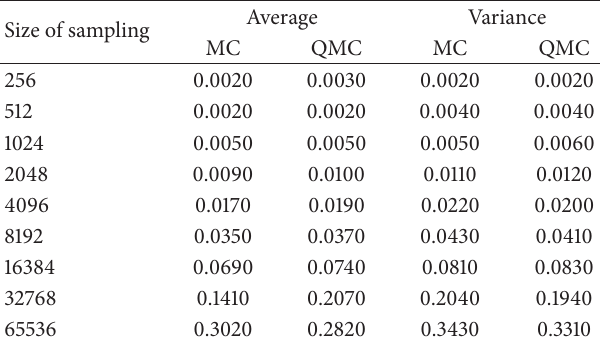
Table 13: Computational time costs achieved by MC and QMC methods to detect the mean and variance of the process 𝑆 𝑇 , at 𝑇 = 1 , with parameters 𝑟 = 3 %, 𝜎 = 15 %, and 𝑆 0 = 100 .